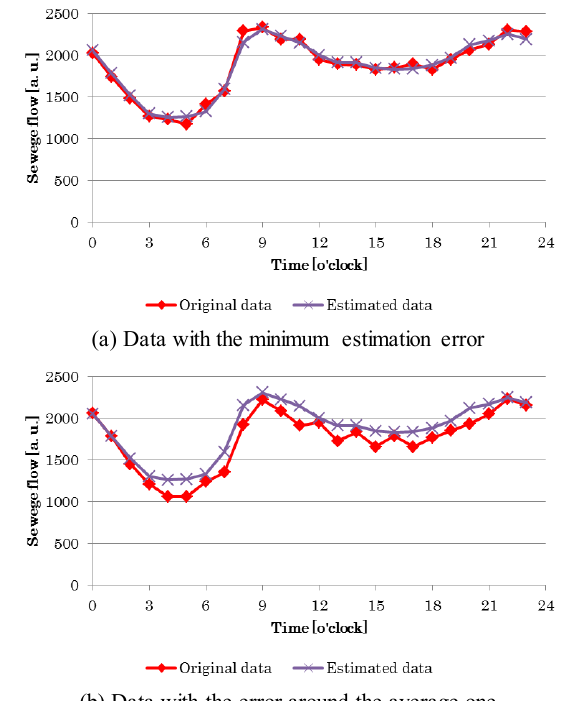
Fig. 7. Estimation of flow patterns considering day